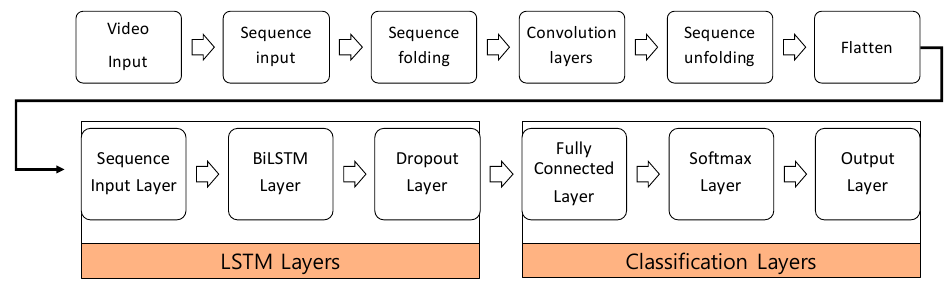
Figure 6. Information flow of CNN-BiLSTM model.